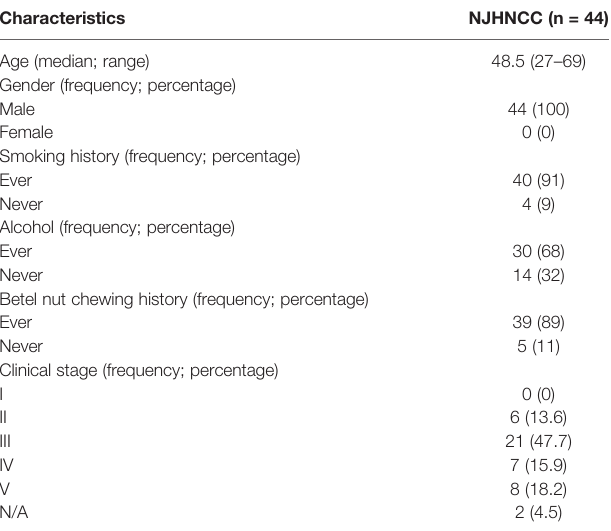
TABLE 1 | Demographic characteristics of 44 HNSCC patients from NJHNCC.